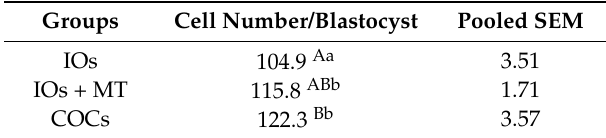
Table 3. The effect of melatonin on Blastocyst cell number of IVF embryos using inferior